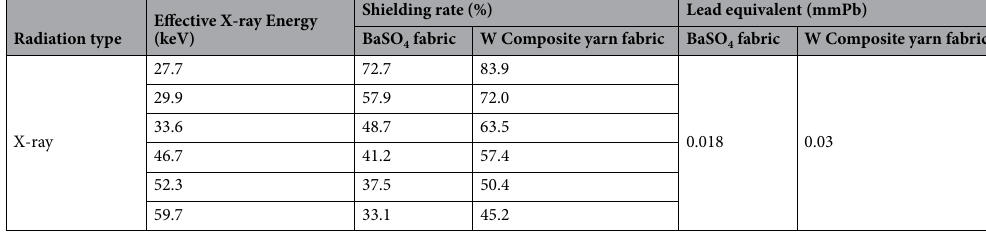
Table 4. Shielding performance evaluation results of the barium sulfate-based fabric and tungsten composite yarn-based